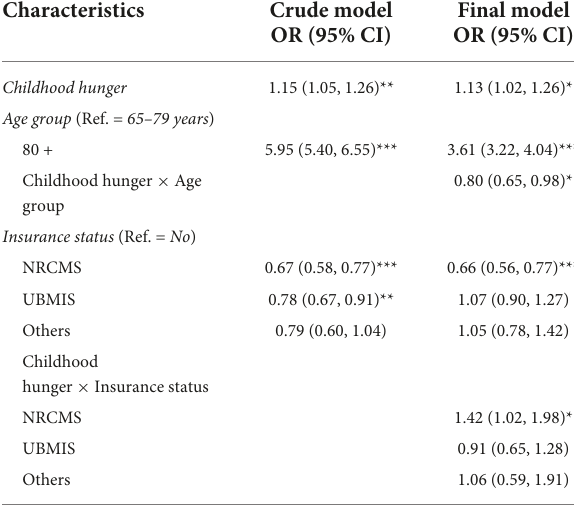
TABLE 4 Effect of the interaction between childhood hunger and age, and insurance status on